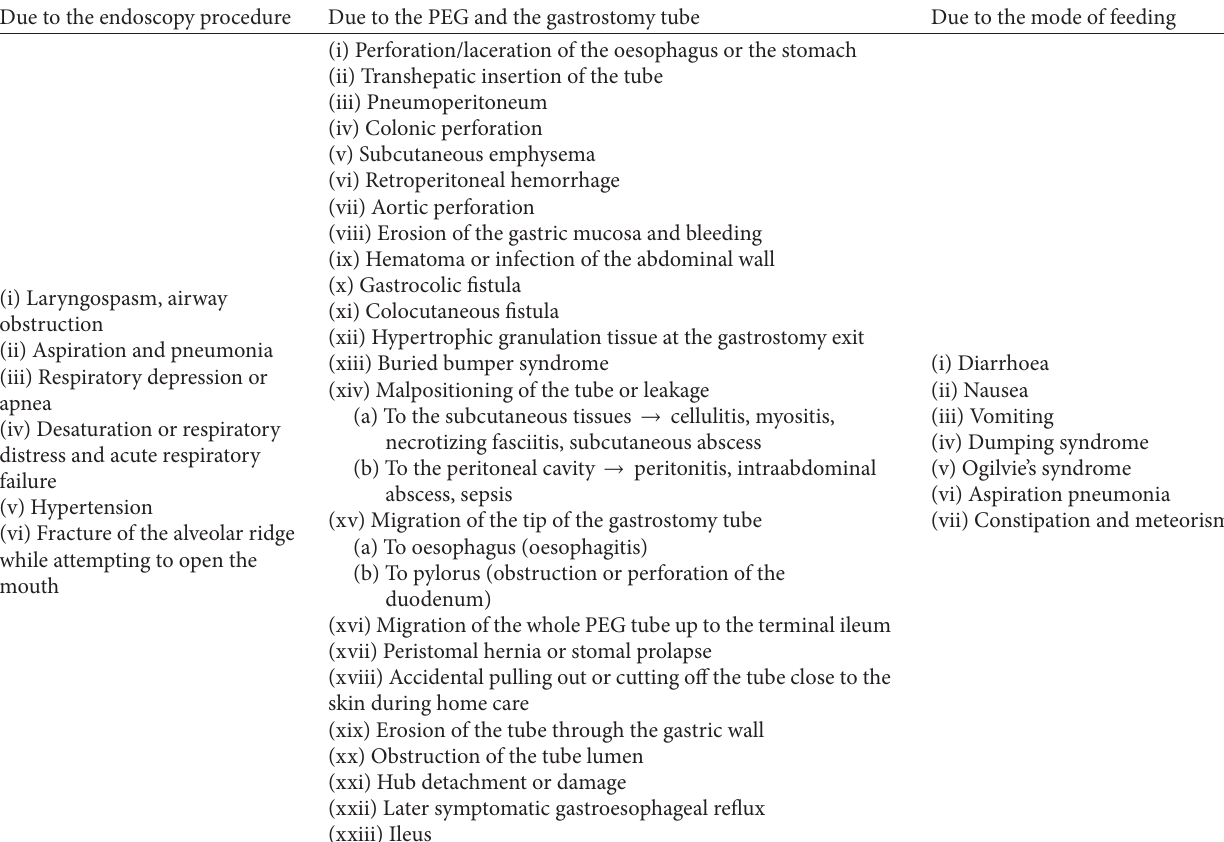
Table 1: Complications of PEG